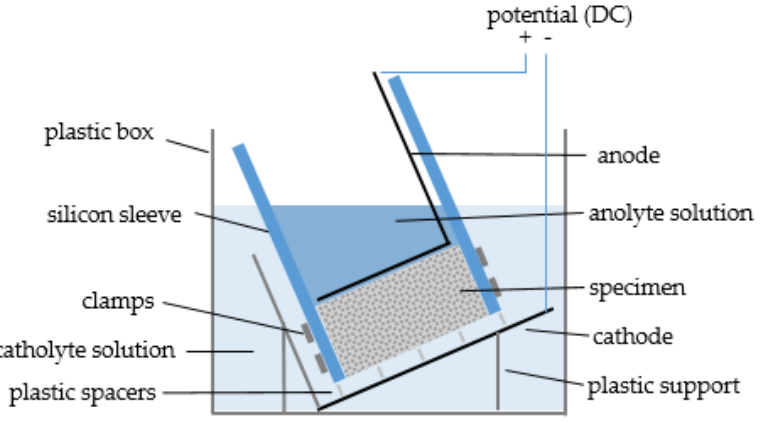
Figure 2. Theoretical scheme of the RCM setup.